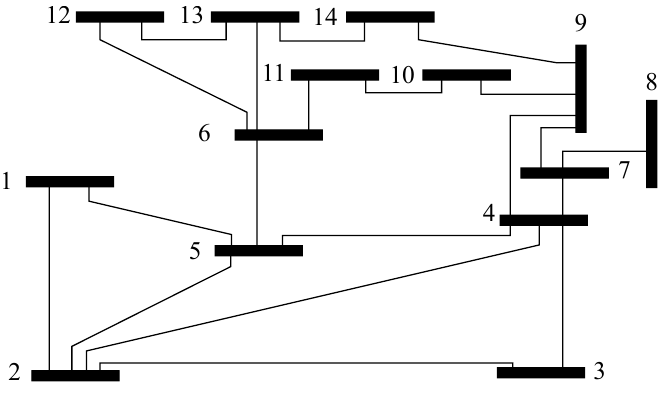
Figure 2. Schematic of the IEEE-14 bus system. Table 1. IEEE 14-bus network lines resistance (p.u.).